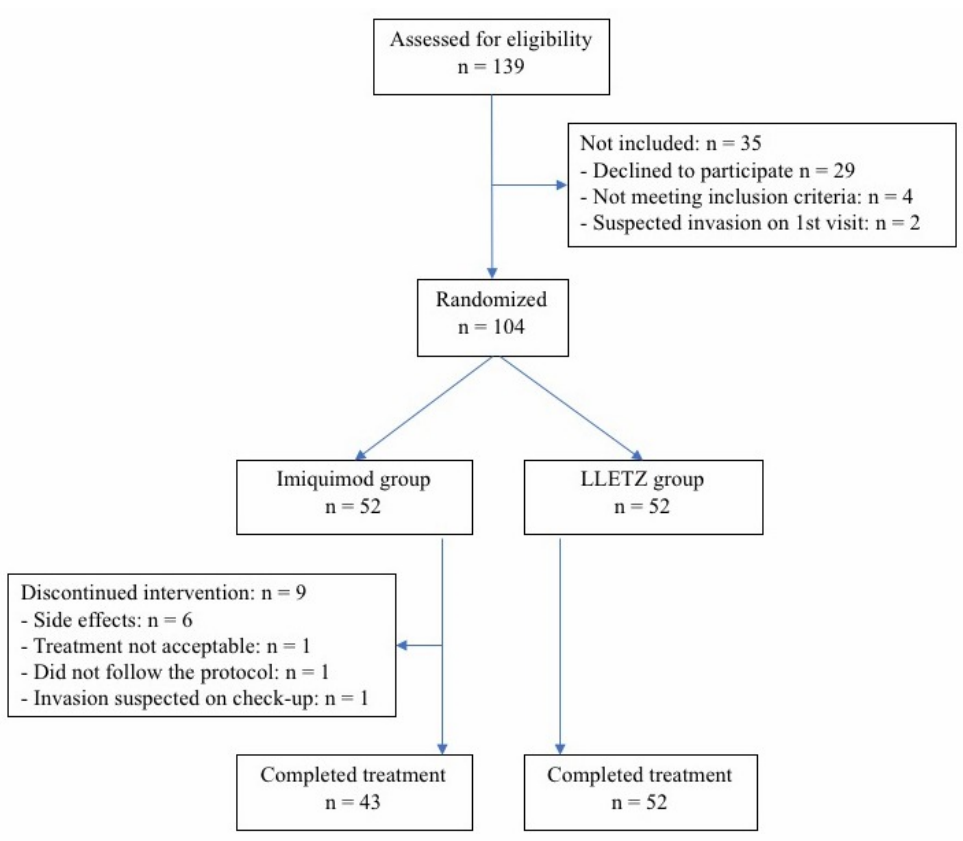
Figure 1. Flow diagram of the study.